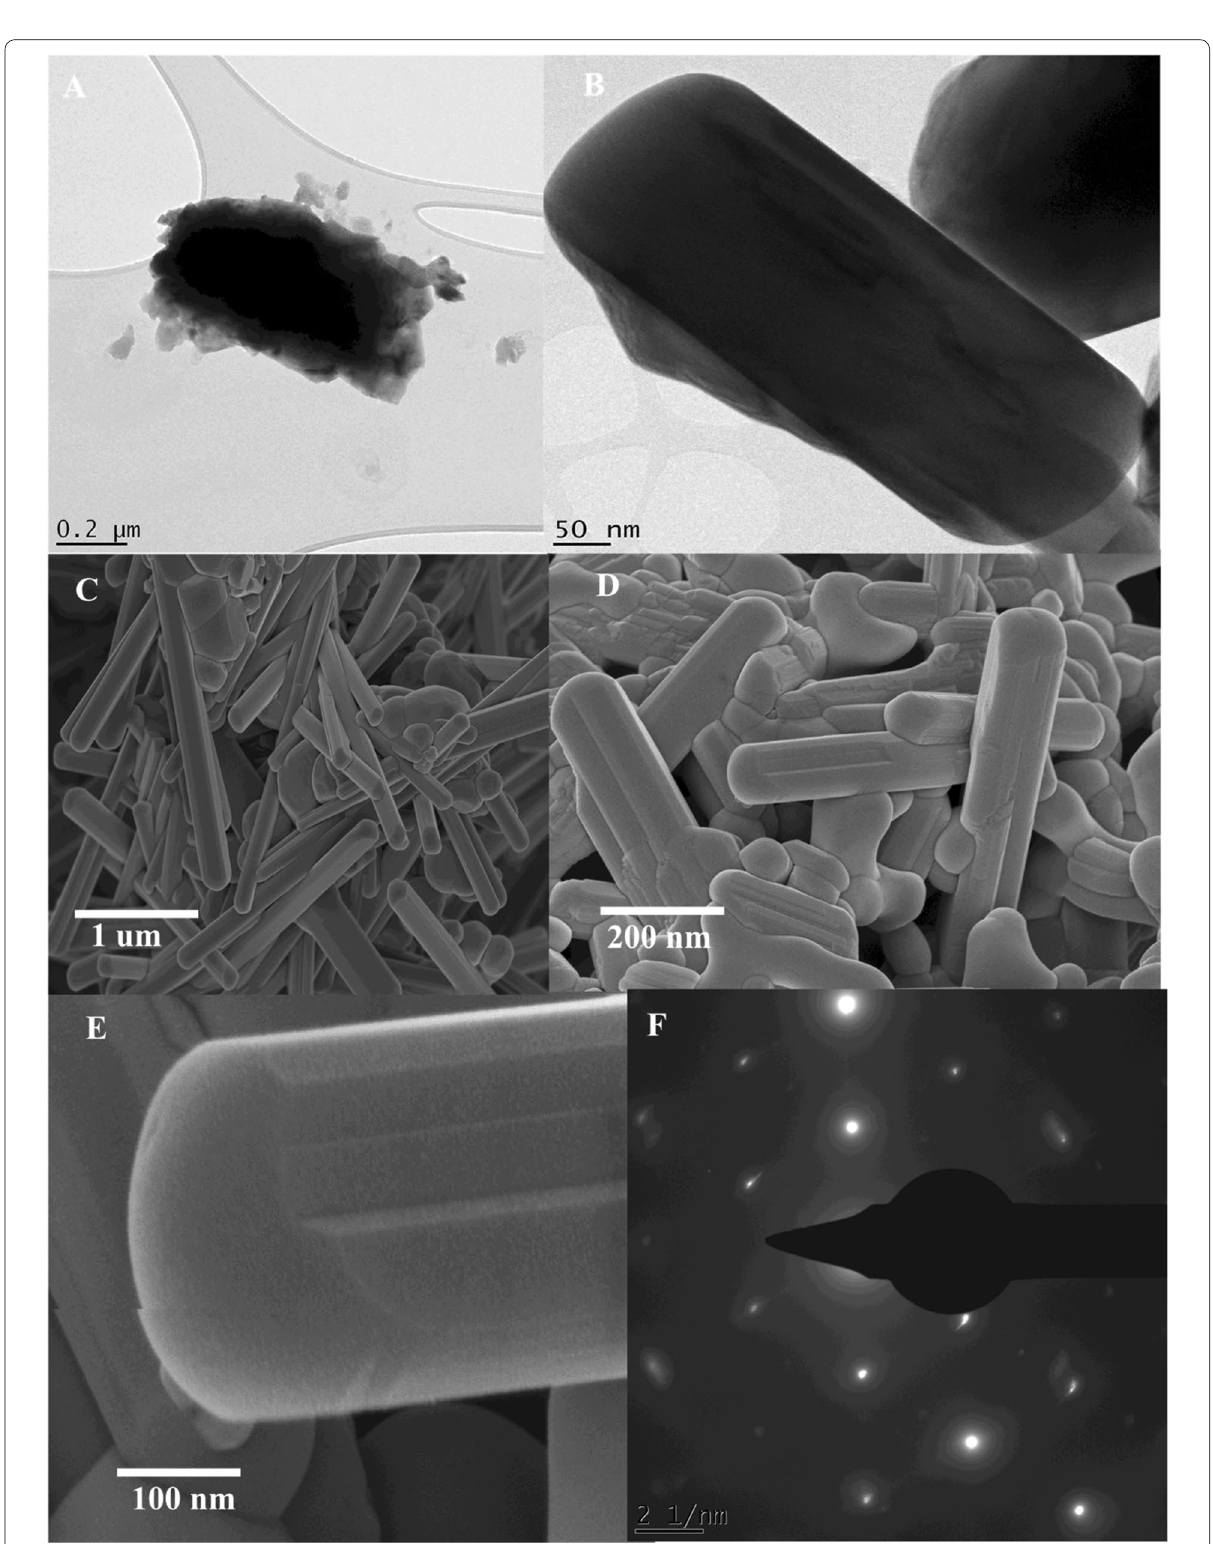
Fig. 4 High resolution microscopic images of BiVO 4 nanorods; A , B HR-TEM images; C – E HR-SEM images; F SAED